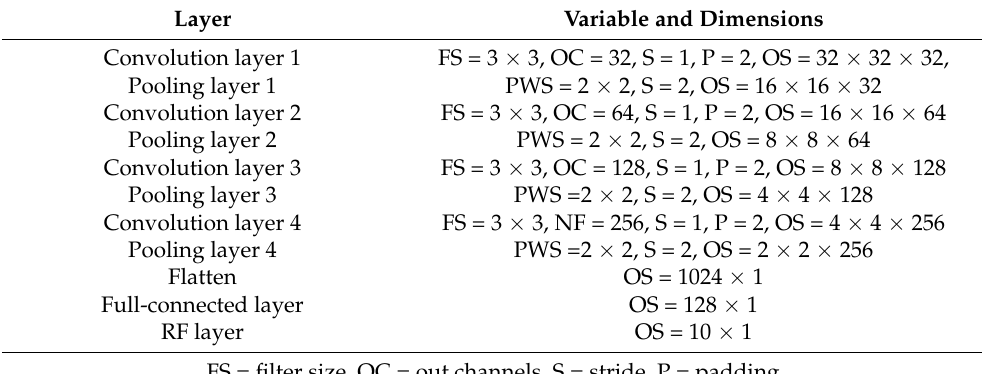
Table 2. Model-parameter